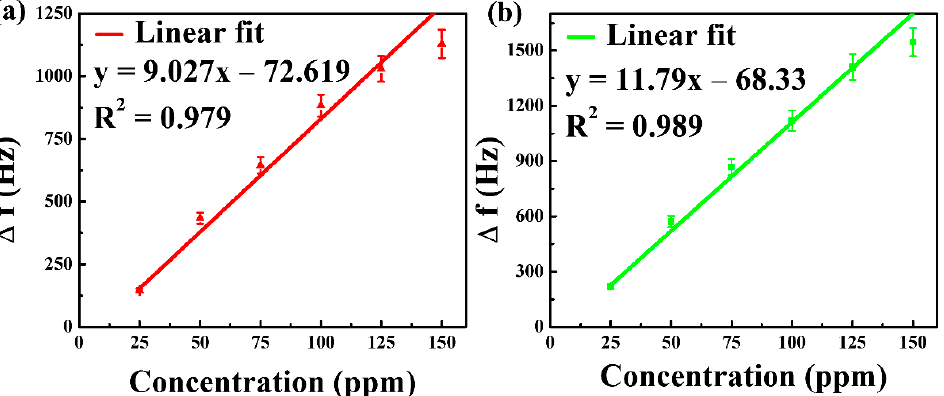
Figure 9. Selectivity of ( a ) NGO@MnO 2 , ( b ) NGO@MnO 2 /PPy in the SAW sensor, and ( c ) the polar plot of response ratios (R3/R4) between the NGO@MnO 2 /PPy-coated and NGO@MnO 2 -coated SAW ( T = 20 °C, R.H. = 25–30%).